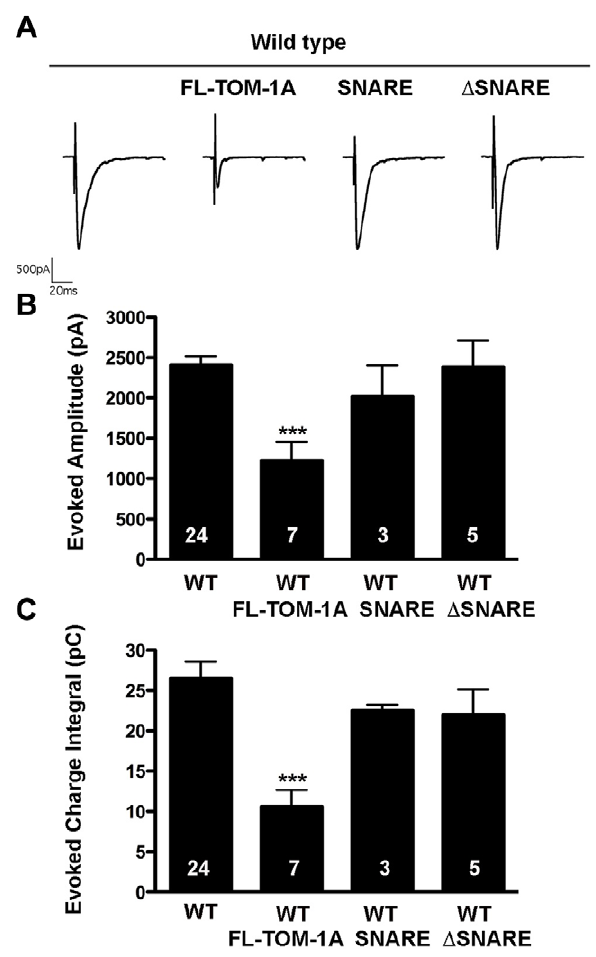
Figure 5. Over-expression of TOM1-A SNARE or D SNARE constructs do not inhibit synaptic release in the wild-type background. A. Representative evoked traces for full-length TOM-1A (SY1237), SNARE (SY1234) and D SNARE (SY1235) expressing transgenes in the wild-type background. ( B ) Average evoked amplitude and ( C ) Average charge integral were only significantly reduced by full-length TOM-1A relative to wild type (***, p=0.0005, and p=0.0007 for B and C, respectively). All data are expressed as mean 6 SEM, the sample size (n) is indicated as a number in each bar, significance values obtained with the Mann Whitney